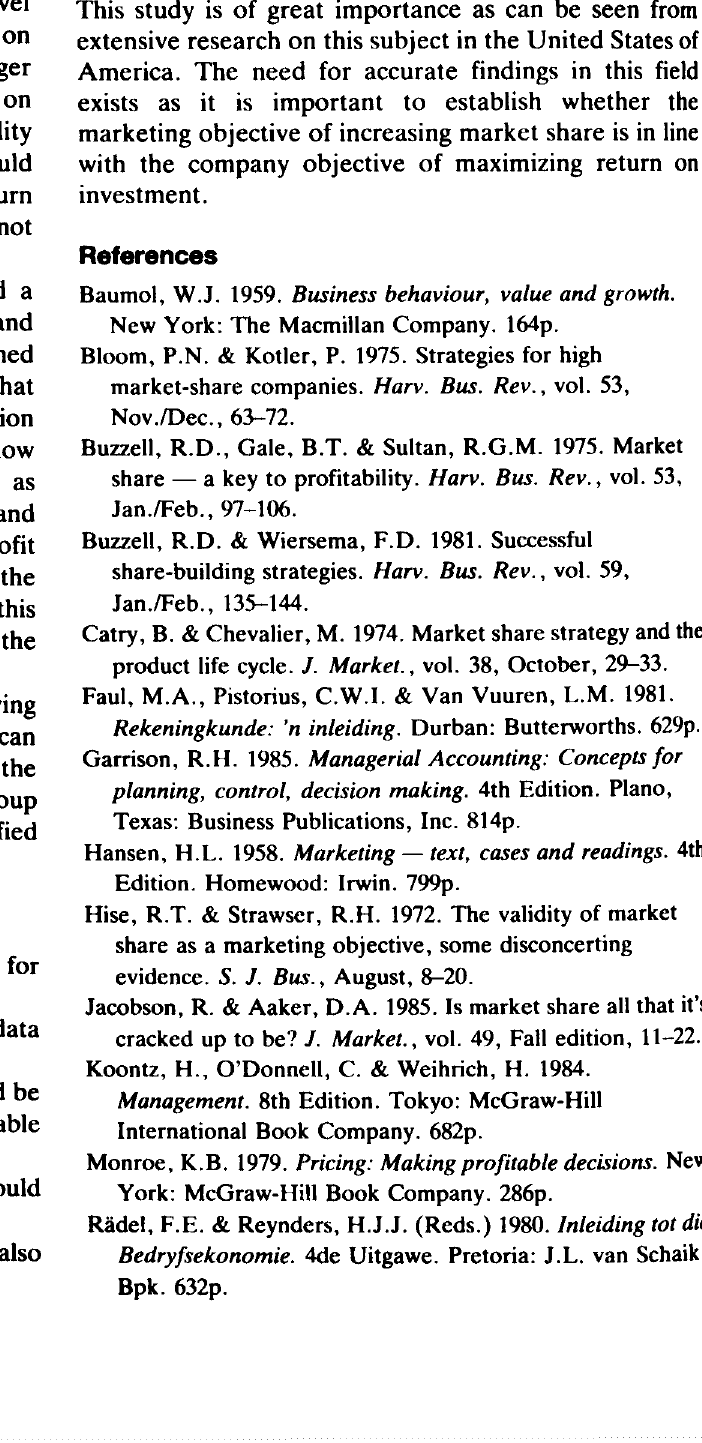
Figure 1 South African business cycle: 1966-1985. (Adapted from: University of Stellenbosch,